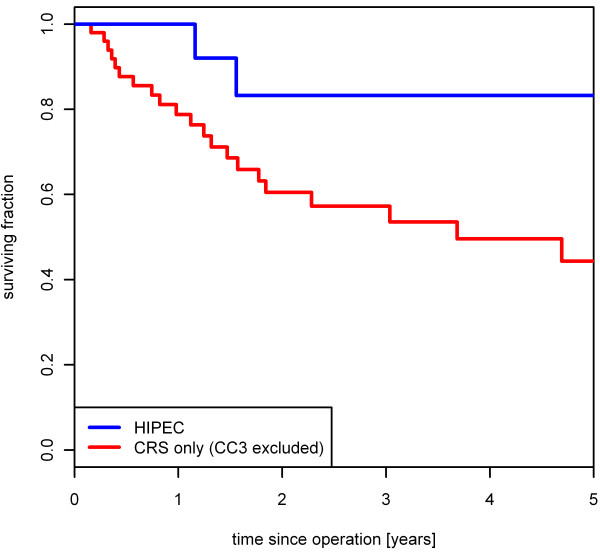
Patient benefit from HIPEC. In the HIPEC group, 2- and 5-year survival rates were each 72.5%, compared to patients with CRS only (CC3 score excluded) with 2- and 5-year survival rates at 52.0% and 38.3%, respectively (N = 70; P = 0.043).